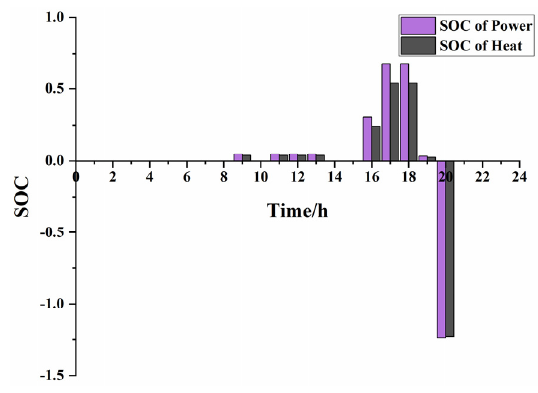
Figure 8. SOC of power and heat in the SA-CAES hub.